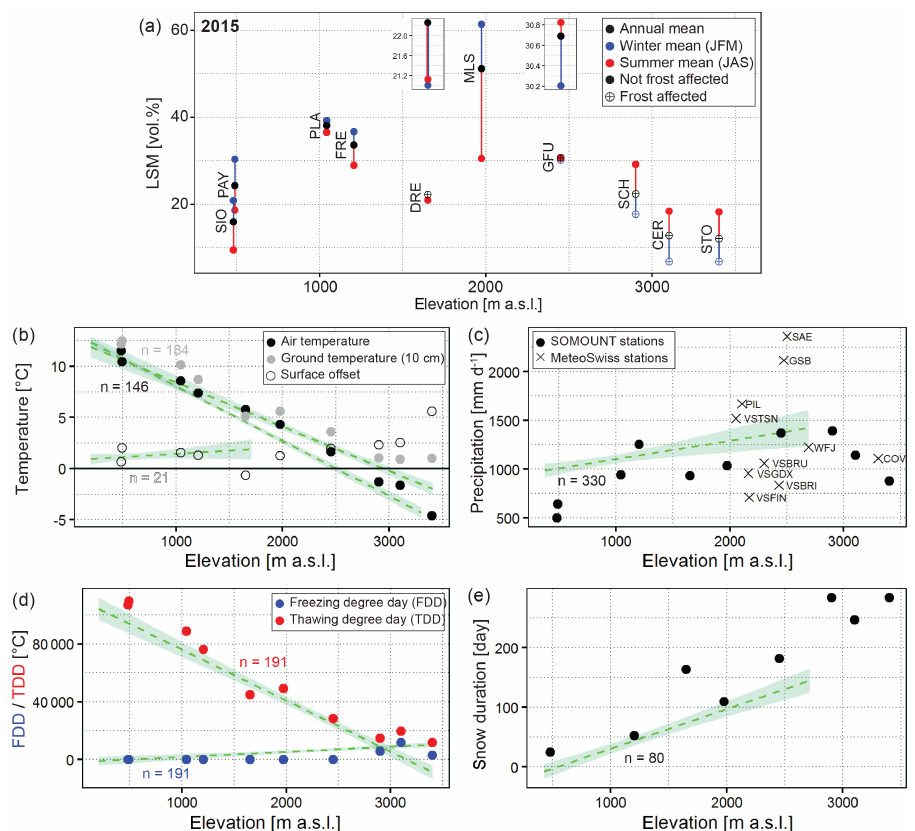
Figure 12. Elevation dependency of the winter, summer and annual mean LSM at 30cm depth (a) , air, ground temperature and surface offset (ground minus air temperature) at 10cm (b) , annual precipitation sum including selected SwissMetNet stations for comparison (see Fig. 1) (c) , freezing and thawing degree days (calculated from ground temperatures at 10cm) (d) and snow duration (calculated from ground temperature at 10cm using the method described in Staub and Delaloye, 2017) (e) during the year 2015. The LSM values for SIO, PAY and PLA are part of the SwissSMEX network (Mittelbach and Seneviratne, 2012). Due to missing data at 30cm, the LSM shown for PAY and PLA was measured at 50 and 20cm at CER. The dashed green lines illustrate the linear regression based on all available SwissMetNet, PERMOS and IMIS stations in Switzerland (the numbers of station with complete data series in 2015 are indicated) and the shaded areas represent the 99% confidence intervals. The length of each regression line corresponds to the maximum elevation of the available